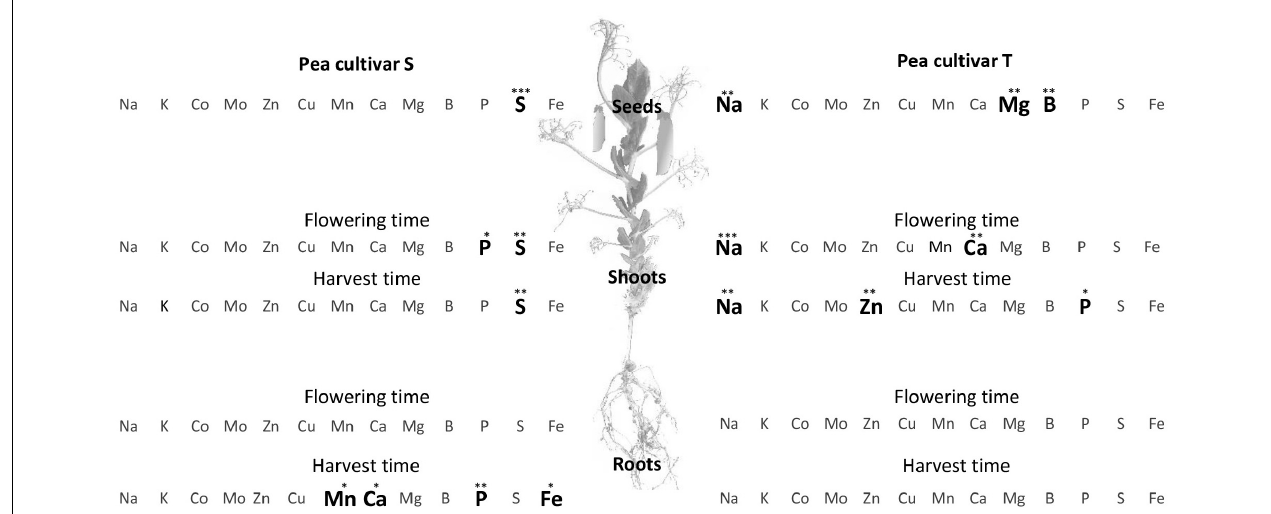
FIGURE 1 | Comparison of elemental concentration in two pea cultivars, tolerant (T) and susceptible (S) to iron chlorosis, grown in a calcareous loam soil under field conditions ( n = 4). Bold characters highlight those elements for which the concentrations were significantly higher in one cultivar, as compared to the other, within a same plant compartment and at a same sampling date. ANOVA p -value: * p < 0.05; ** p < 0.01; *** p < 0.001. Data regarding the element compositions of mature seeds are available in Supplementary Figure S1A